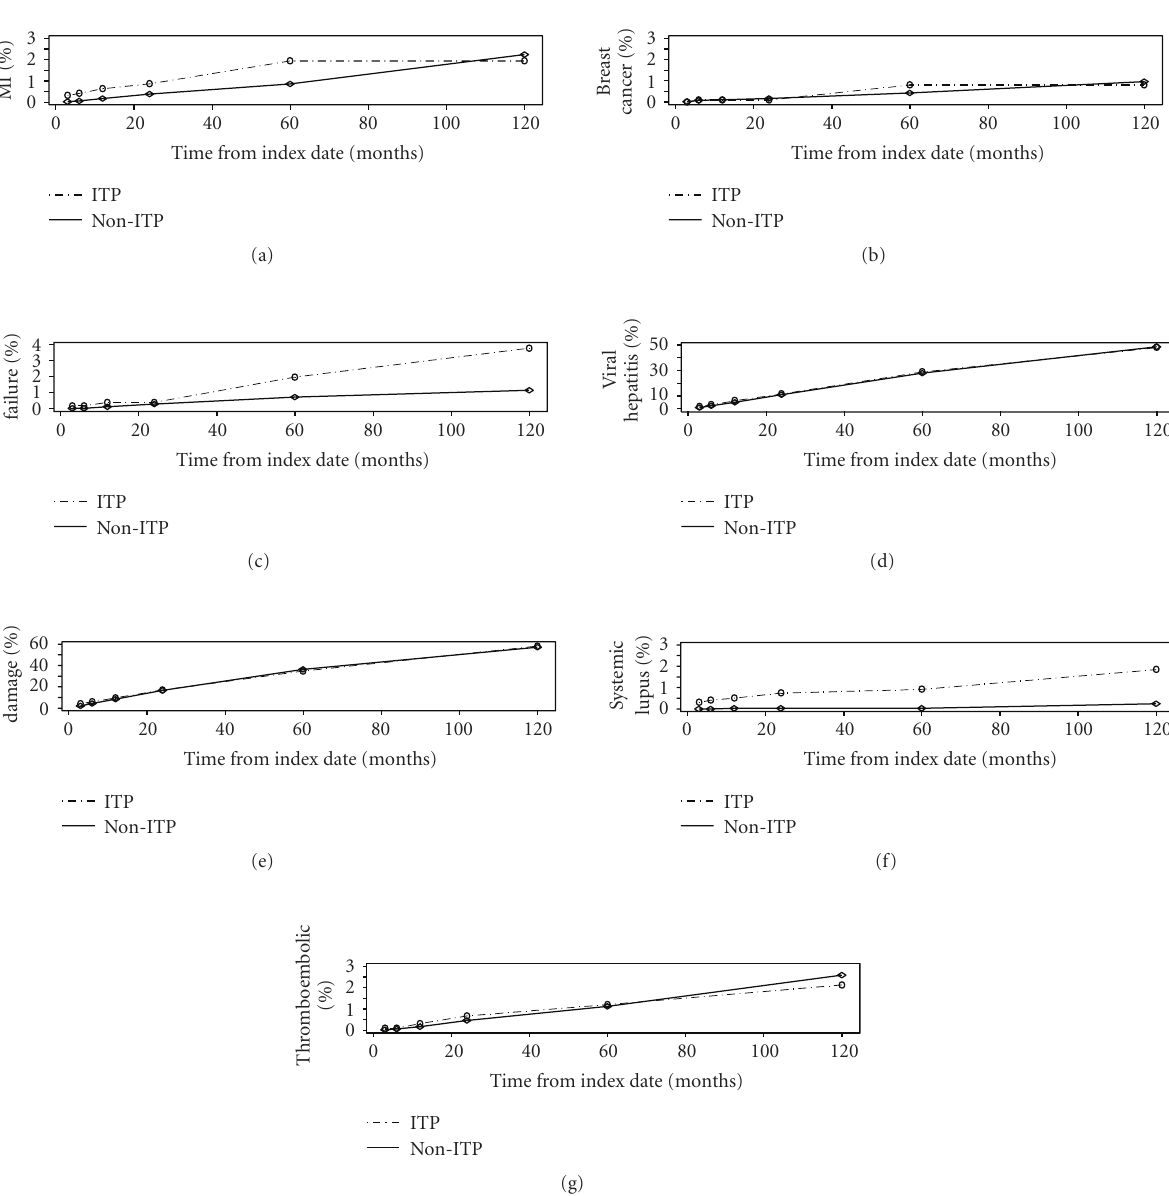
Figure 2: Cumulative risk of 7 grouped conditions over time in ITP and non-ITP